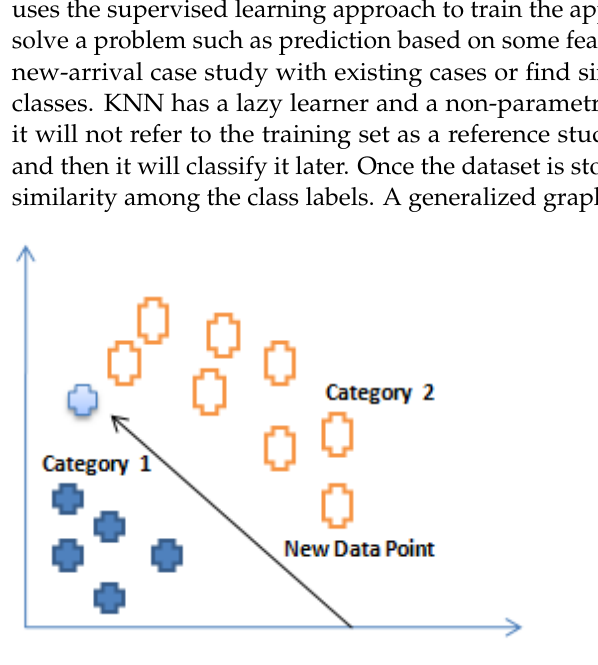
Figure 5. Support vector machine algorithm.